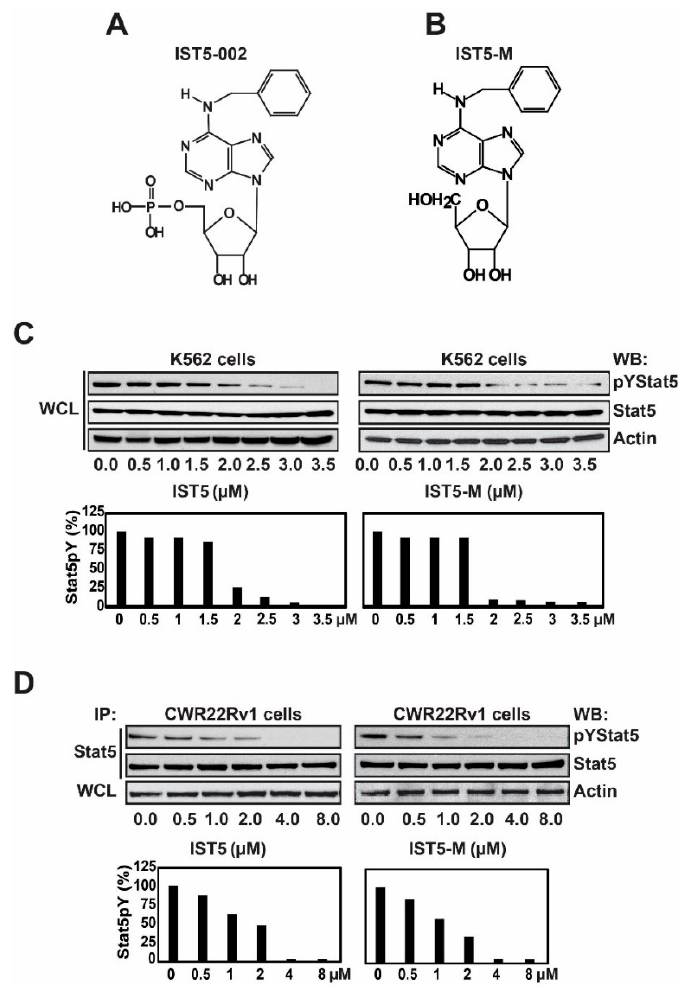
Figure 4. IST5 and the IST5-derivative lacking the phosphate group (IST5-M), both, inhibit Stat5 phosphorylation in CML and prostate cancer cell line with high efficacy. ( A ), chemical structure of IST5-002 (IST5). ( B ), chemical structure of IST5-M (IST5 without the phosphate group. ( C ), IST5 and IST5-M both inhibit Stat5 phosphorylation in CML cells (K562) with high efficacy. K562 cells were treated with IST5 and IST5-M for 4 days at the concentrations indicated. Whole cell lysates (WCL) were immunoblotted with anti-pYStat5 mAb, anti-Stat5 mAb and anti-actin mAb as loading control. ( D ), IST5 and IST5-M, both, decrease Stat5 phosphorylation in PC cells (CWR22Rv1). CWR22Rv1 cells were treated with increasing concentrations of IST5 and IST5-M for 4 days. Stat5 was immunoprecipitated (IP) followed by immunoblotting (WB) with anti-pYStat5 mAb and anti-Stat5 mAb. Whole cell lysates (WCL) were immunoblotted with anti-actin mAb as loading control.